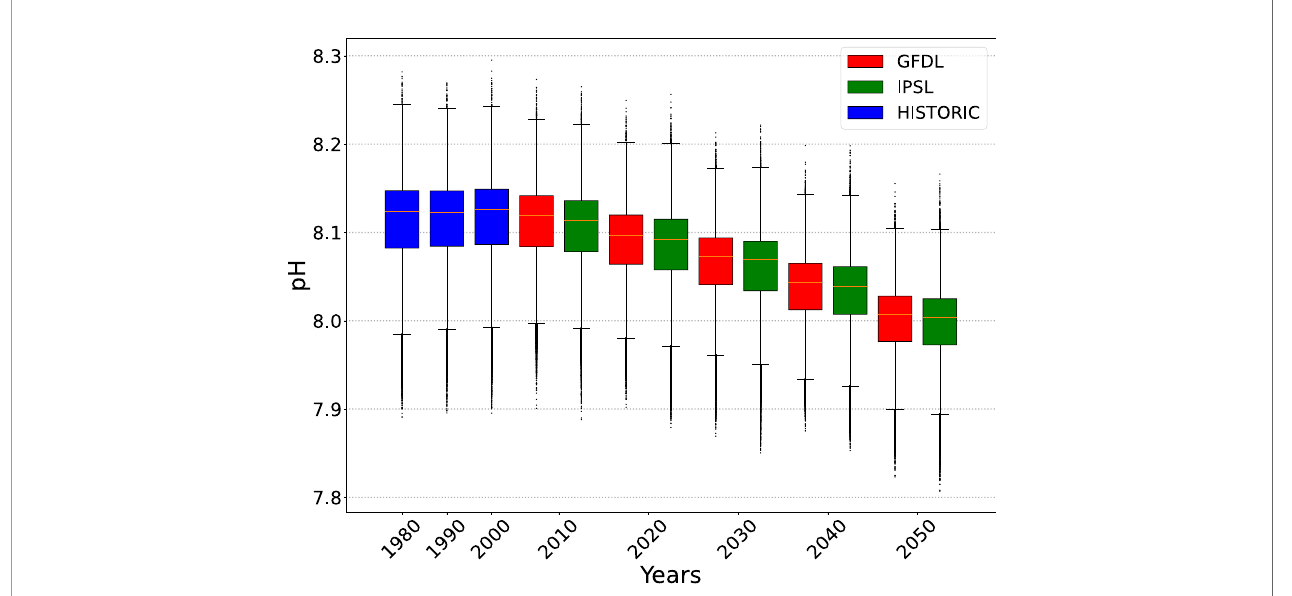
FIGURE 2 | Boxplots on the distribution of pH in the epipelagic layer where yellow fi n tuna larvae are predicted to occur (density threshold is set to 0.1). Data aggregated by decade (1981-1990; 1991-2000; etc). Historical values of pH (HISTORIC) are from the ERA40 INTERIM renanalysis forcings. Future values of pH are from the GFDL and IPSL CMIP6 earth climate models used in the ensemble (see Table 1